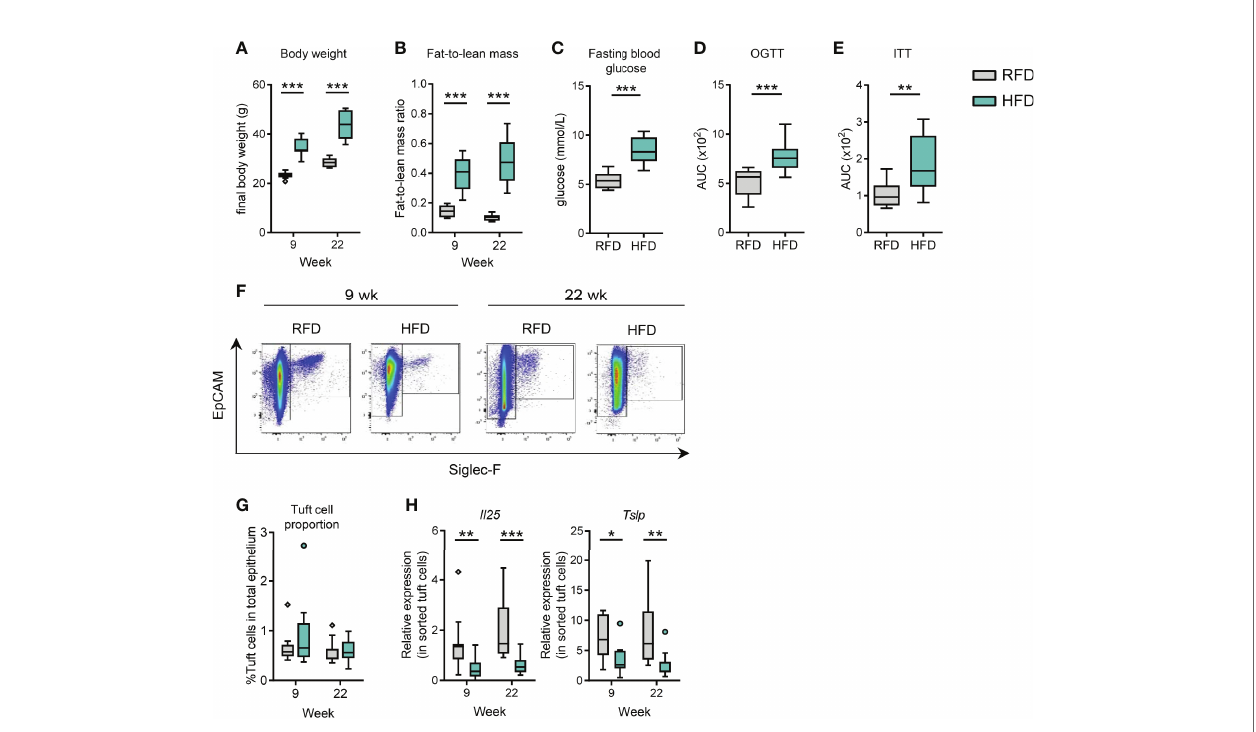
FIGURE 1 | Diet-induced obesity results in decreased small intestinal tuft cell activity. C57BL/6J mice were fed either RFD or HFD for 9 and 22 weeks, respectively. (A) Body weight and (B) fat-to-lean mass ratio at week 9 and 22. (C) Fasting blood glucose at week 20, (D) oral glucose tolerance test (OGTT) at week 20, and (E) insulin tolerance test (ITT) at week 21 in RFD and HFD. (F) Flow cytometry-based analysis of the number of small intestinal tuft cells (EpCAM+ Siglec-F+). (G) Tuft cells quanti fi ed as % of tuft cells out of the total number of EpCAM+ epithelium cells. (H) Expression of Il25 and Tslp mRNA (relative to the tuft cell marker Dclk1 ) as determined by RT-qPCR in sorted intestinal tuft cells. N=10-12 per group, derived from three repeated experiments. * p < 0.05, ** p < 0.01, *** p < 0.001 by Mann- Whitney U test. Graphs depict boxplots showing median (center line), 25th to 75th percentiles (inter-quartile range) (box limits), +/- 1.5 times IQR (Tukey whiskers) and outliers. AUC, area under the curve; RFD, reference fat diet; HFD, high fat